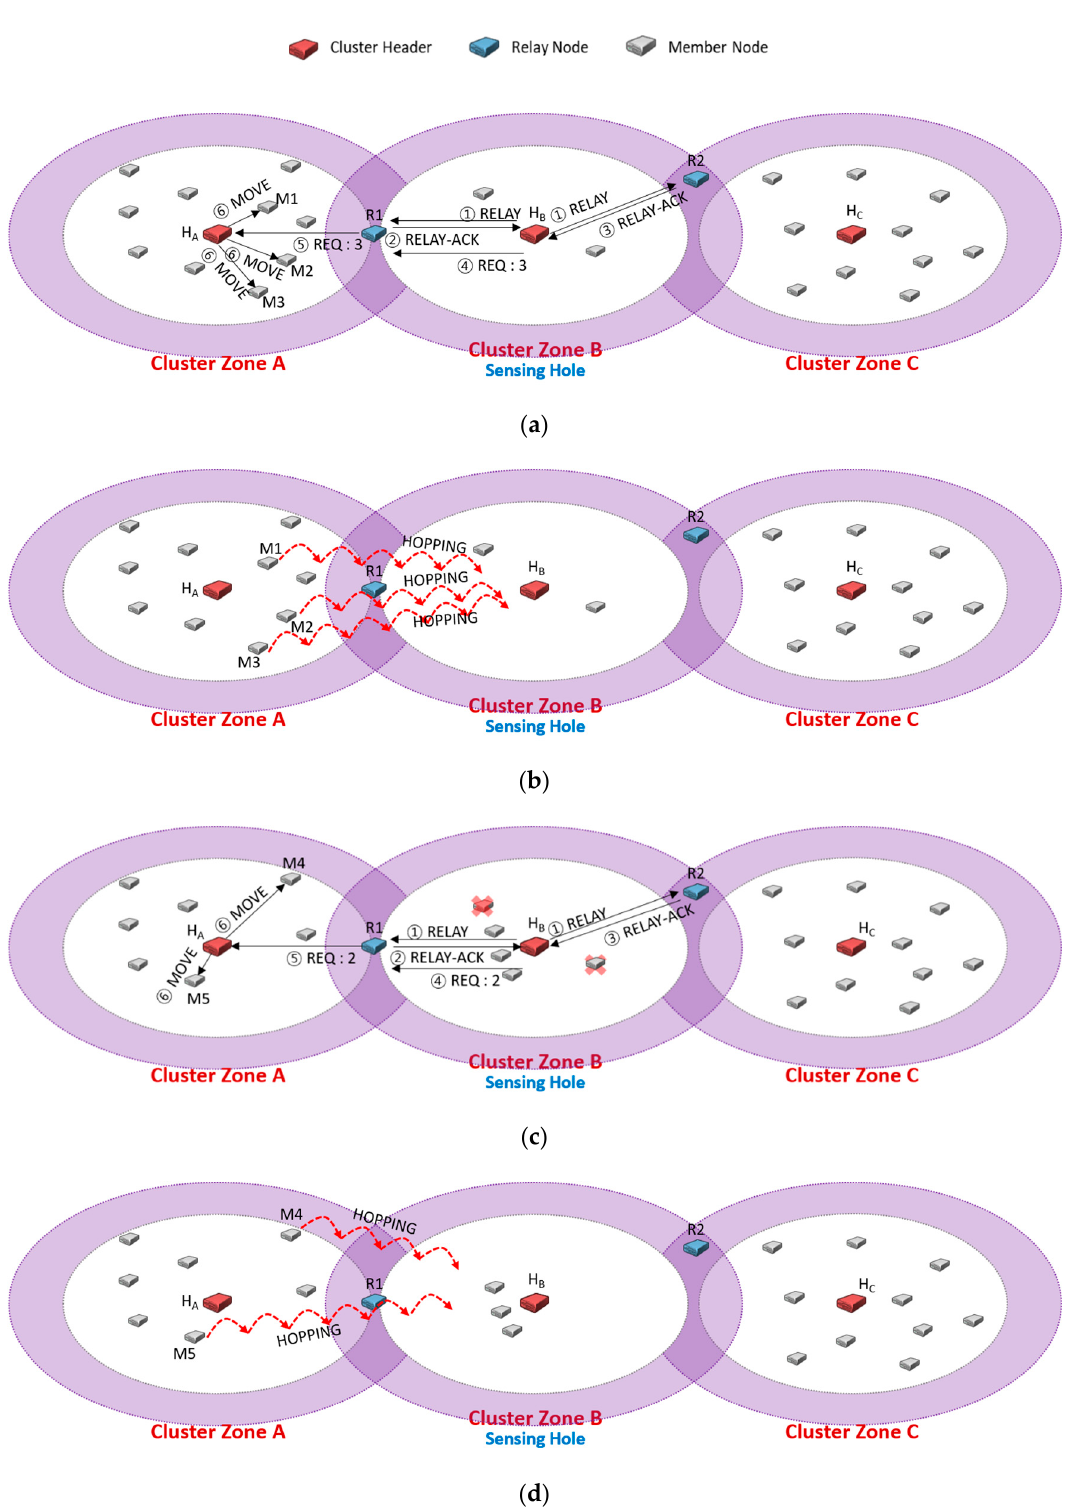
Figure 4. An example of continuously sending a message to request the needed members only to a specific relay node, R1.